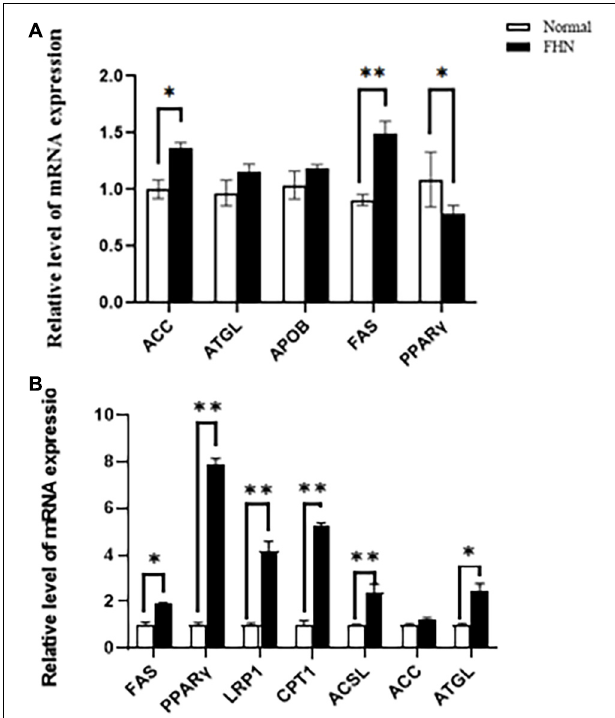
FIGURE 11 | The changes of the mRNA expression of the target genes related to lipid metabolism in the liver (A) and femoral head (B) at the age of 5 weeks. ∗ indicates a significant difference ( P < 0.05). ∗∗ indicates an extremely significant difference ( P <